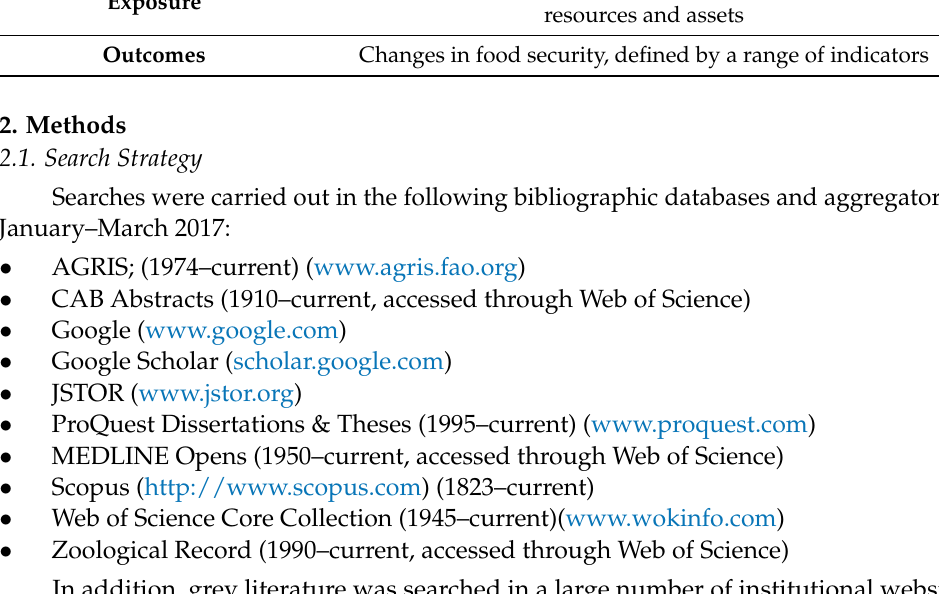
Table 1. Elements of the systematic map question. Forest resources and assets in low- and middle-income countries Subject (as defined by the World Bank, 2014) Women- or female-headed households that access and use forest Exposure resources and assets Outcomes Changes in food security, defined by a range of